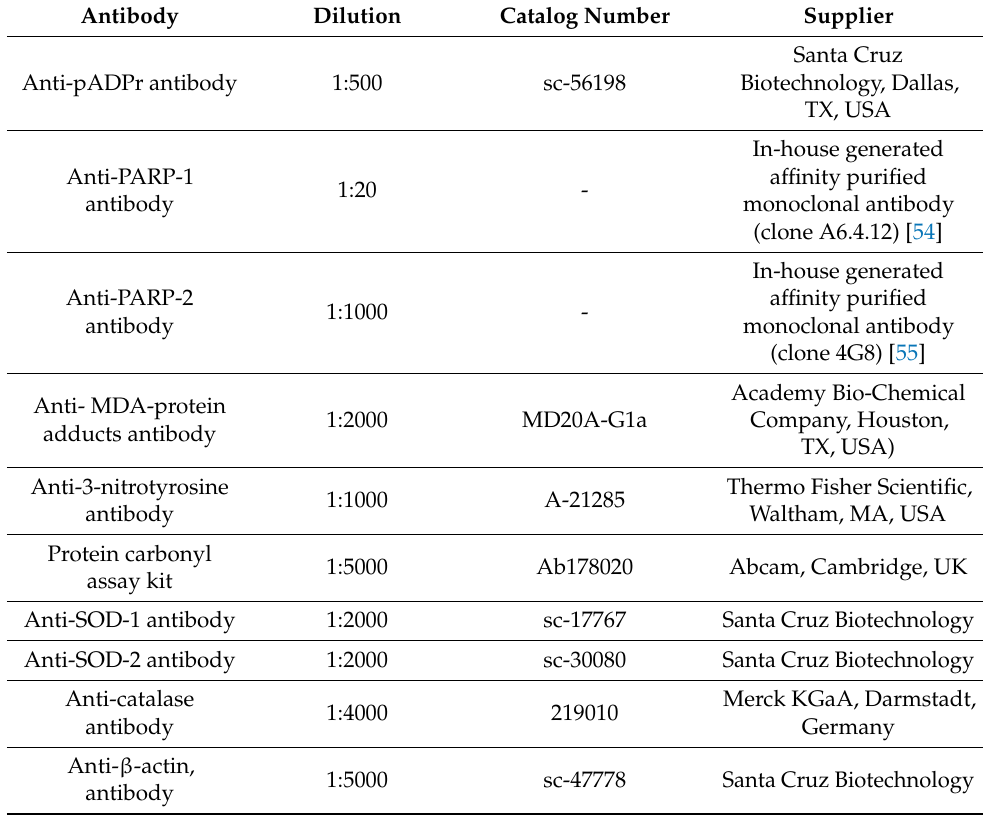
Table 3. List of primary antibodies used in Western blot